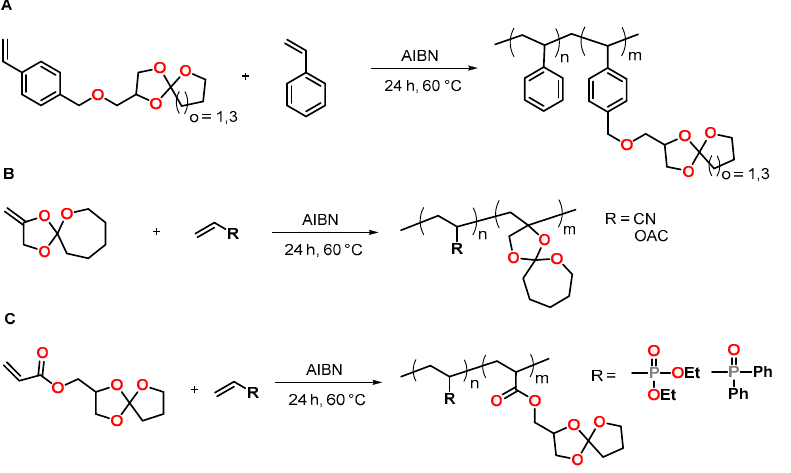
Figure 13. Structural representation of polymers with crosslinkable SOE groups in the sidechain. A : Copolymers of styrene and five/seven-membered SOEs. B : Copolymers of acrylonitrile or vinyl ( A ): Copolymers of styrene and five/seven-membered SOEs. ( B ): Copolymers of acrylonitrile or vinyl acetate with five/seven-membered SOEs bearing unsaturated C=C double bonds. C : Copolymers acetate with five/seven-membered SOEs bearing unsaturated C=C double bonds. ( C ): Copolymers of phosphorous-containing vinyl monomers and SOEs with acrylate groups. of phosphorous-containing vinyl monomers and SOEs with acrylate